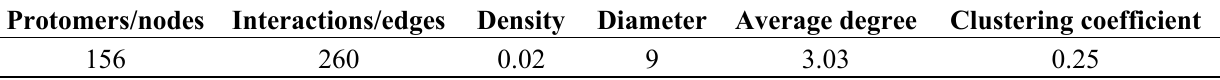
Table 2. GPCR HetNet topological